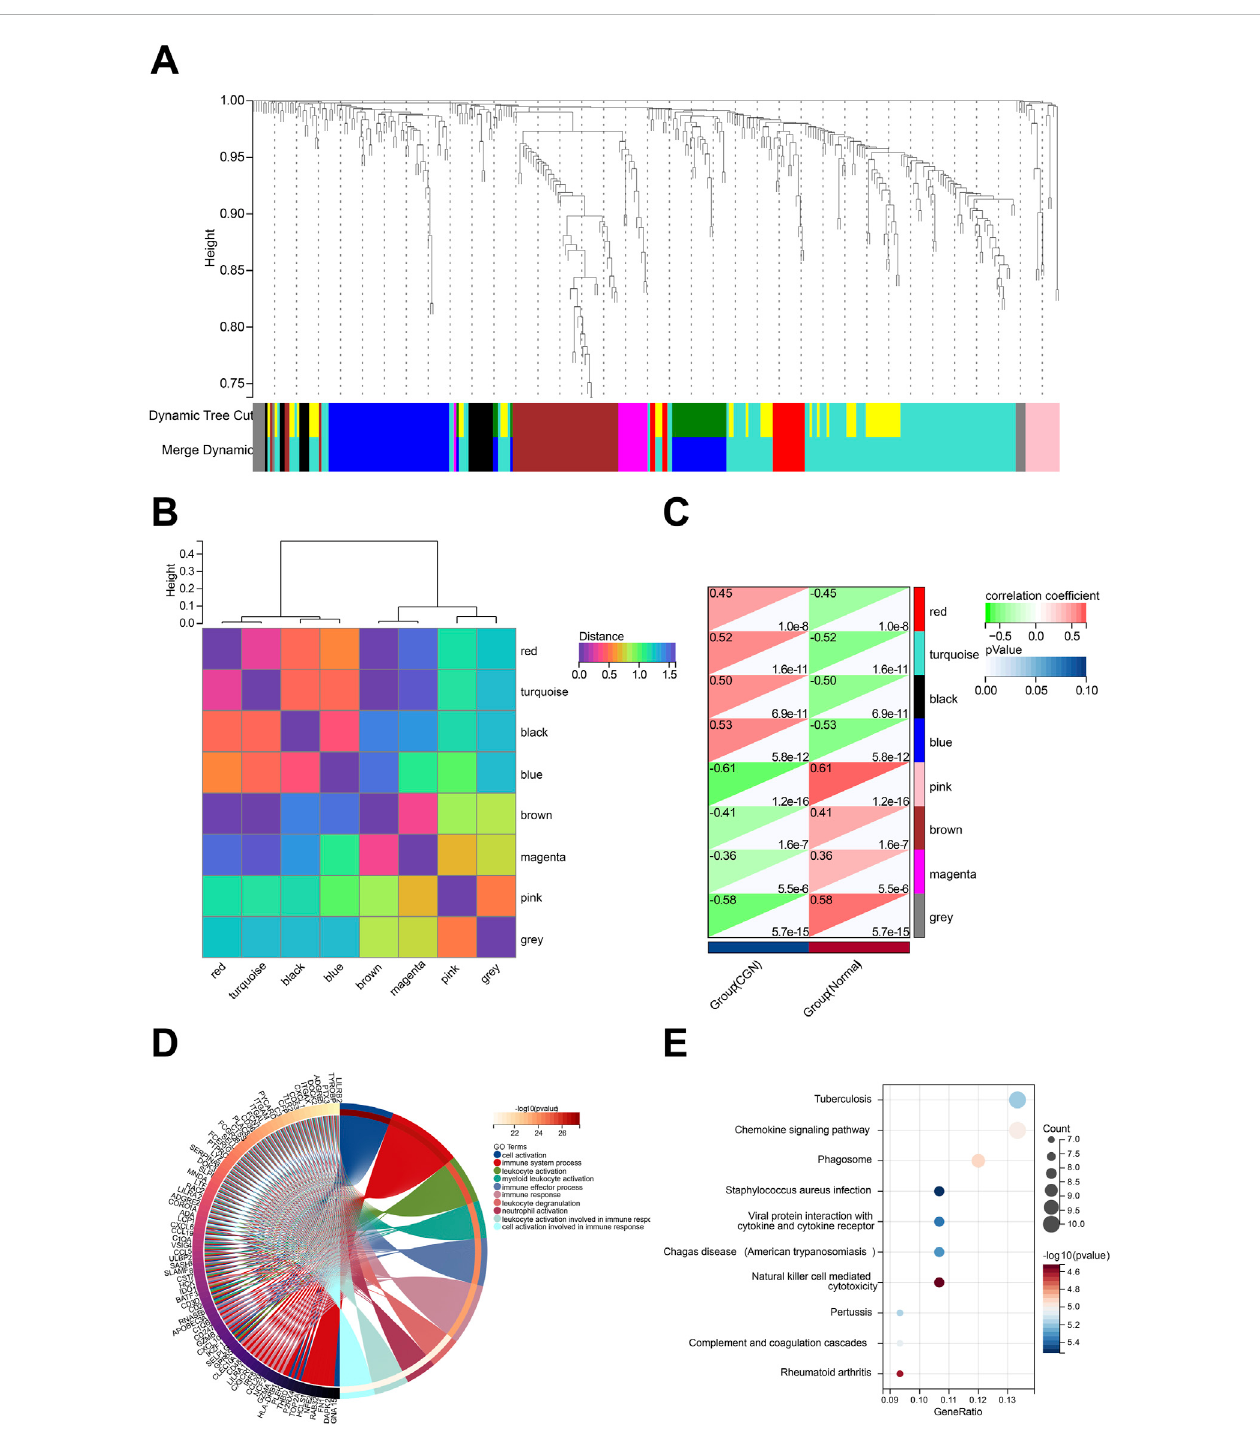
FIGURE 4 Identi fi cation of modules associated with the clinical traits of CKD based on WGCNA analysis. (A) Dendrogram of all differentially expressed genes clustered based on a dissimilarity measure (1-TOM). (B) Clustering heatmap of module feature vector. (C) Heatmap of the correlation between module eigengenes and clinical traits of CKD. (D) Top 20 of GO biological processes analysis. (E) Top 20 of KEGG pathway analysis.